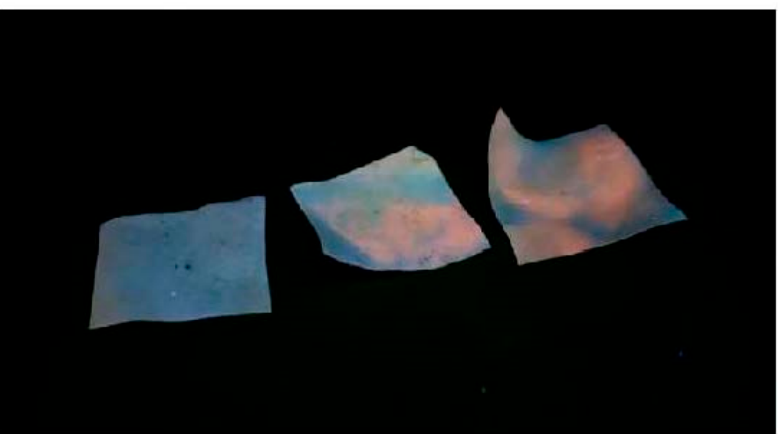
Figure 6. Real color images of complex 5 before (left image) and after (middle and right images) adding increasing amounts of HS − . Middle image: [NaSH] = 50 µ M; right image [NaSH] = 100 µ M.